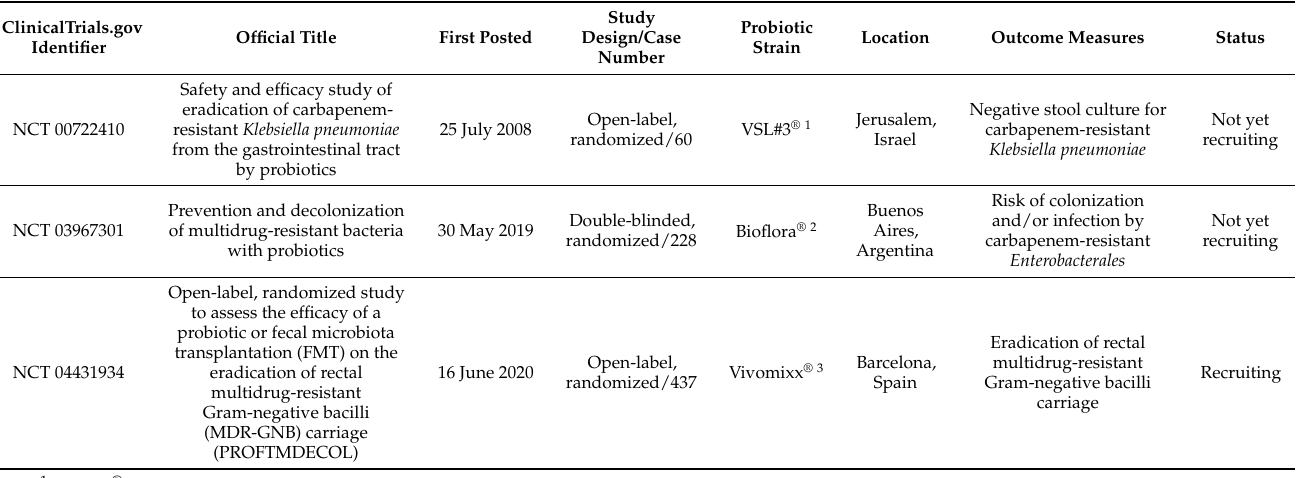
Table 3. Three clinical trials of dietary supplementation with probiotics for the eradication of gut Enterobacterales carriage registered at ClinicalTrials.gov, as posted from July 2008 to July 2021. ClinicalTrials.gov